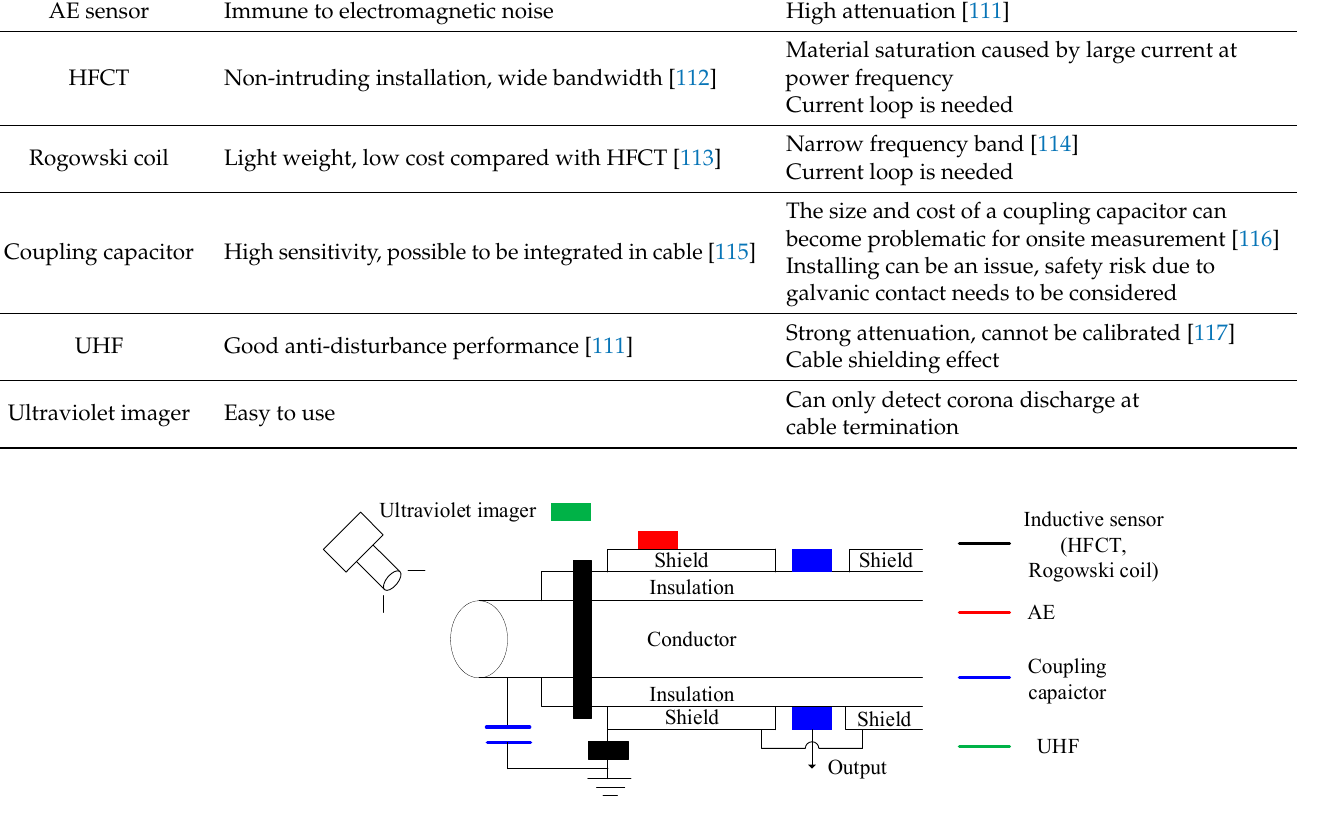
Table 4. PD sensors with advantages and disadvantages.